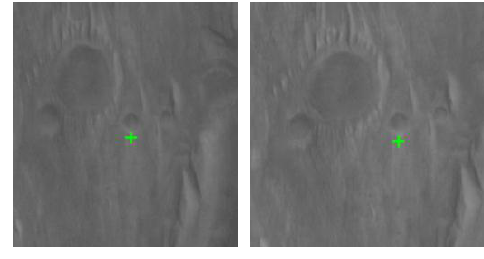
Figure 5. back-projection conjugate points from orthophotos to original